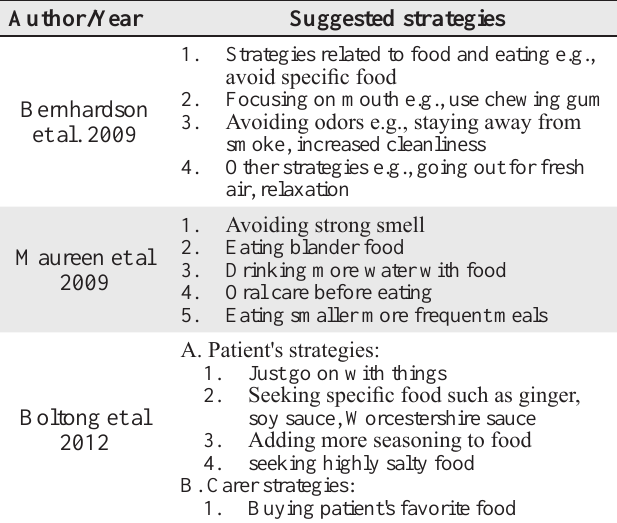
Table 2 : Summary of studies examining behavioral